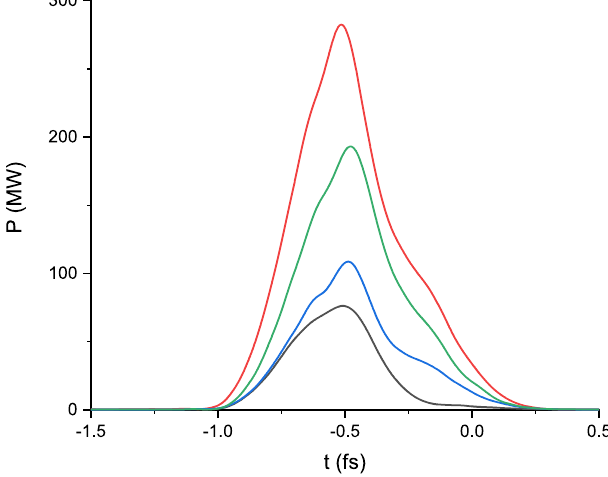
FIG. 7. Radiation power for four representative shots at 9.3 nm. Bunch head is on the left